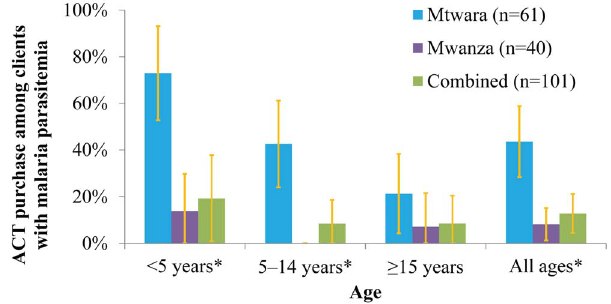
Figure 4. Malaria Parasitemia Prevalence Stratified by Age and Region.